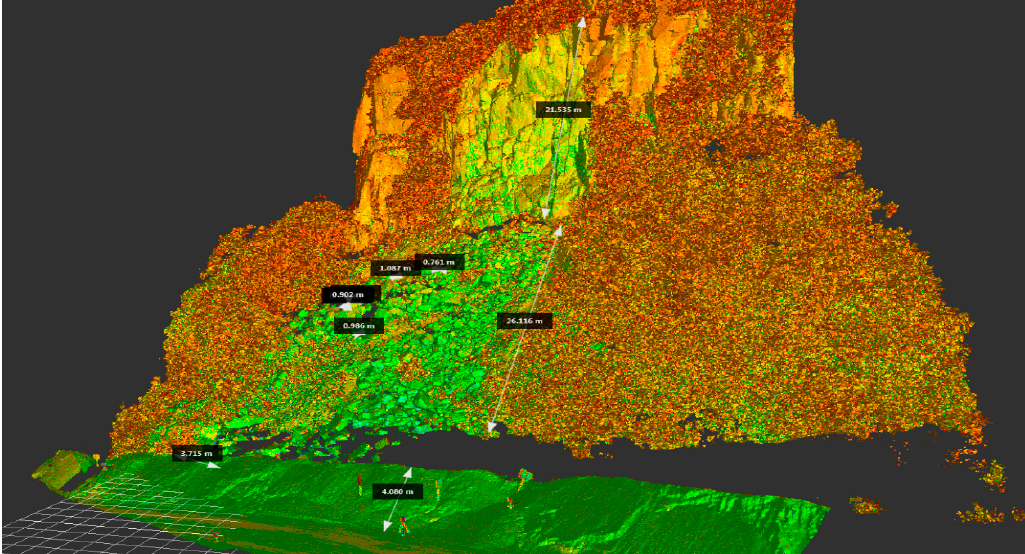
Figure 3. Registered TLS (terrestrial laser scanning) point cloud image, with illustrative sample dimensions highlighting the sub-vertical rock wall and the scree slope. Given the inaccessibility of the inner side of the rockfall trap, the TLS was unable to capture its complete geometry. Some sample measurements were taken and highlighted as to show the indicative vertical drop from the source area to the base of the slope, and the length of the scree slope/transition zone. The same measurements were used to obtain a representative block size on the rock wall.